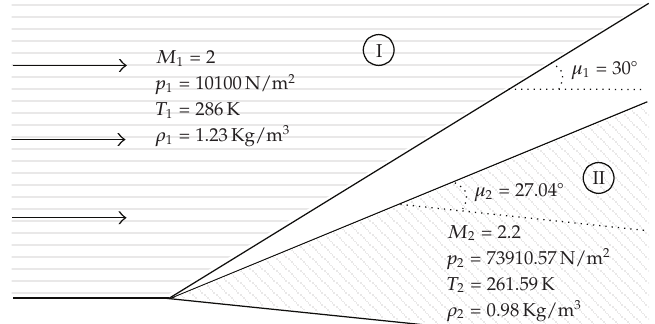
Figure 6: Analytical solution of the expansion corner.